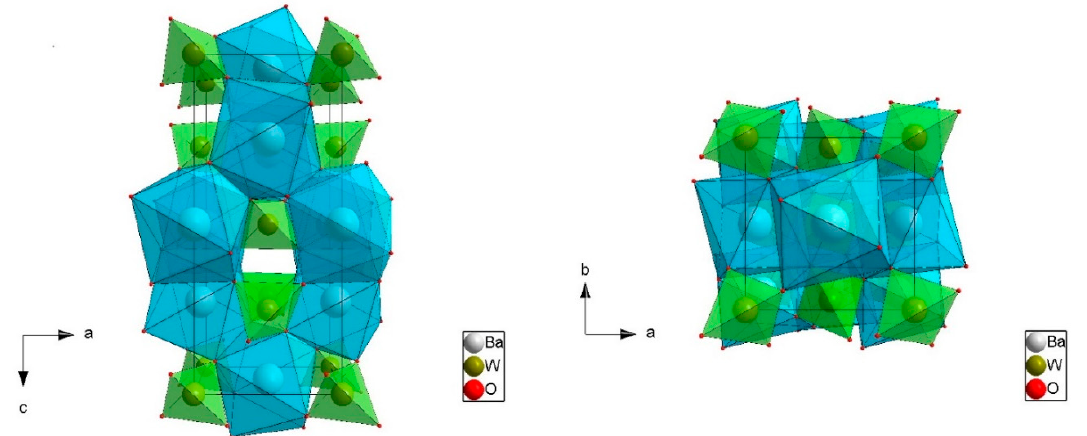
Figure 1. Unit cell structure of BaWO 4 viewed along the b -axes ( left ) and c -axes ( right ) with marked dodecahedra [BaO 8 ] (blue) and tetrahedra [WO 4 ] (green).